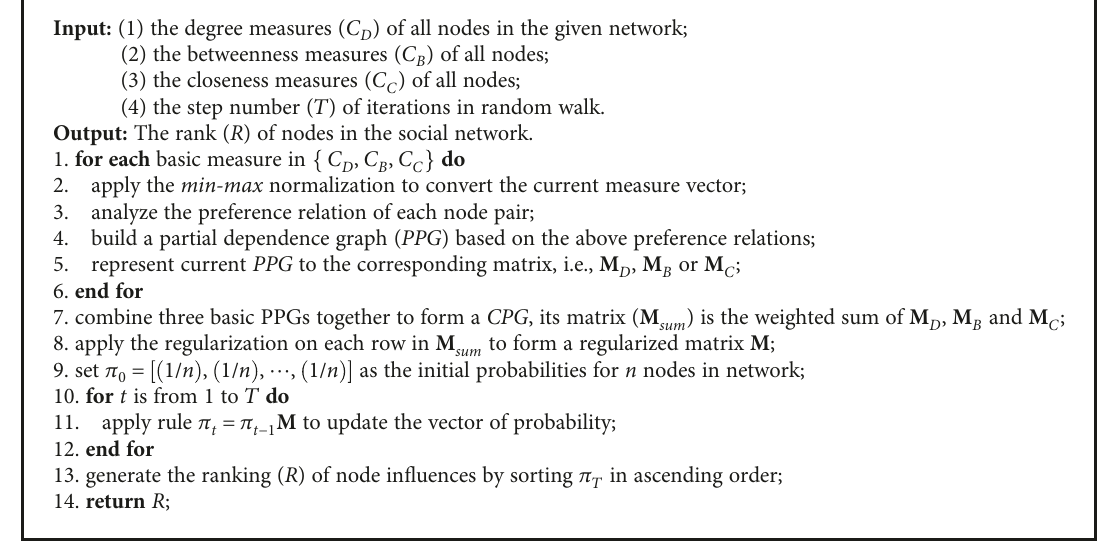
Algorithm 1: PARW-Rank Algorithm. Table 3: The basic statistical features of six real-life